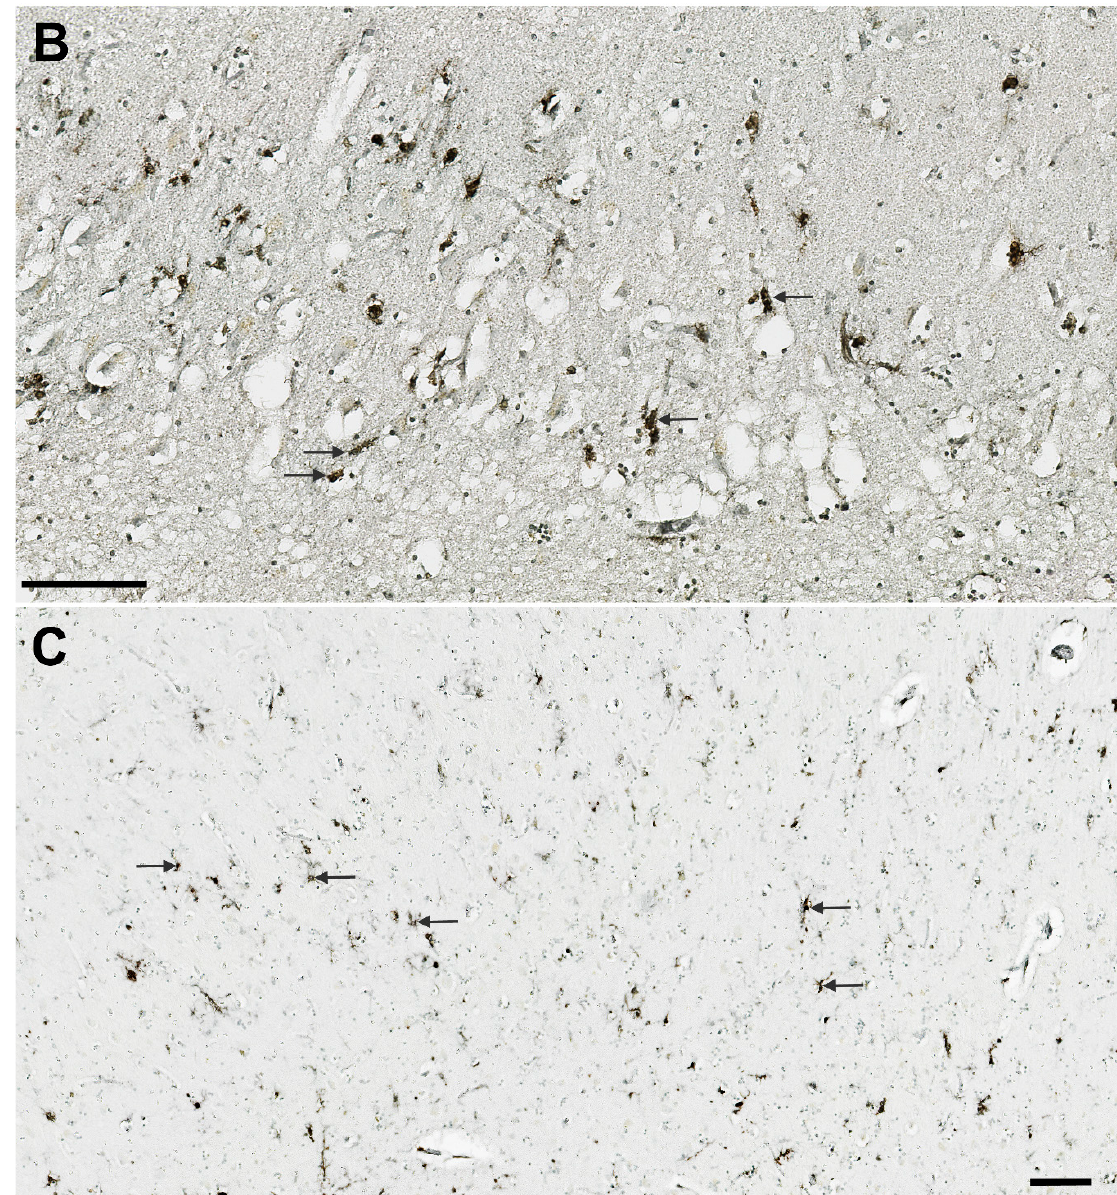
Figure 6. HLA-DR immunohistochemical staining of microglia (arrows) in AD. Hilar part of the CA3 ( A ), CA2/3 ( B ), and subiculum ( C ). The higher magnifications in A and B allow for the recognition of different morphologies of microglial cells, while panel C offers a broader view of their regional distribution. Scale bars 100 μ m.